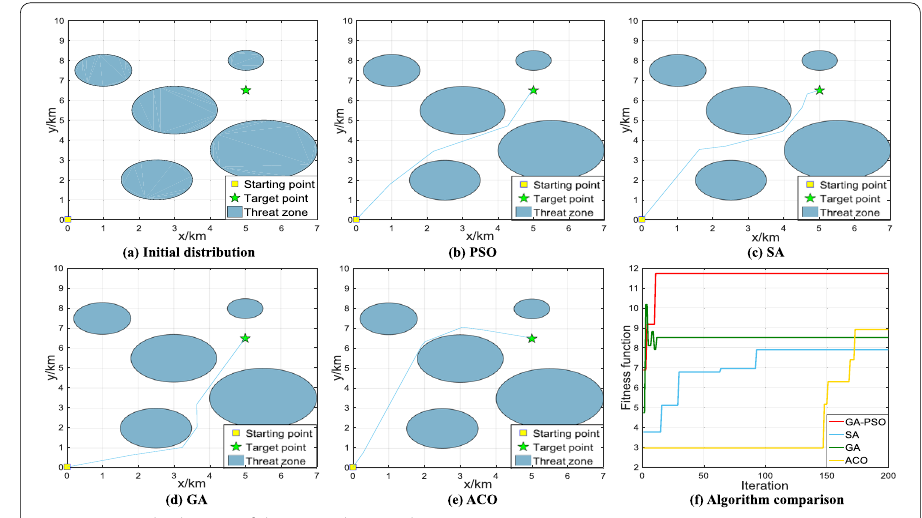
Fig. 9 Optimal solutions of the second route planning test